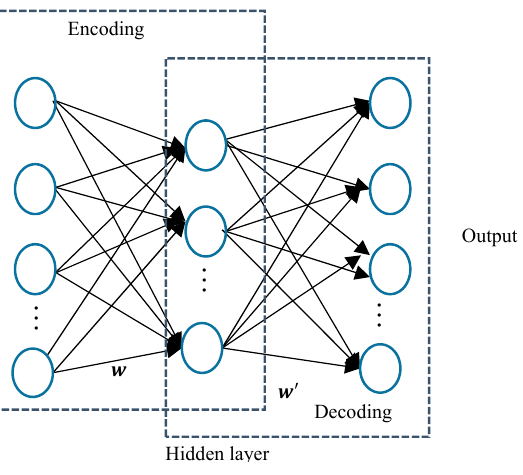
Figure 2. Scheme of single autoencoder.